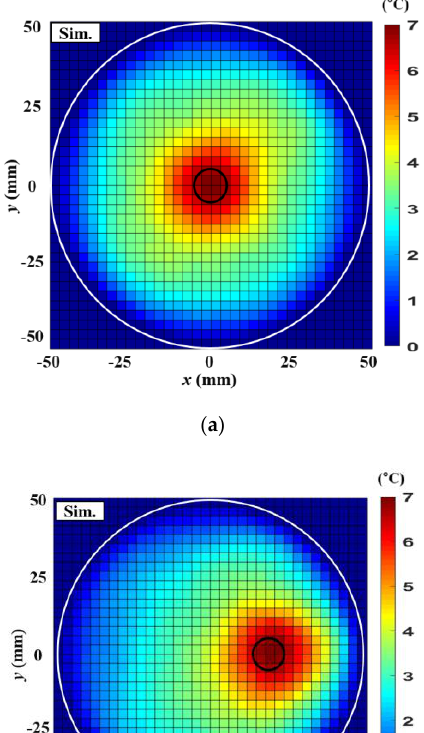
Figure 11. ( a ) Configuration of the temperature measurement setup, and ( b ) block diagram of the temperature measuring system [25].